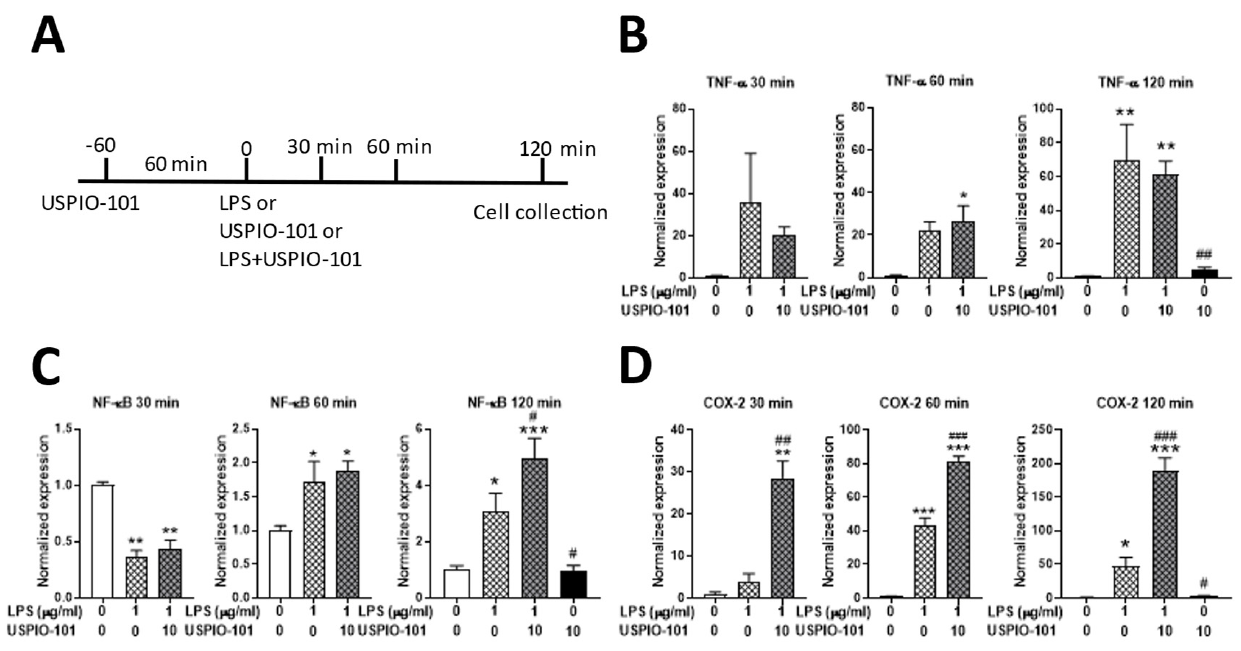
Figure 6. USPIO-101 potentiates the LPS-induced NF-kB and COX-2 mRNA expression in SM826 microglial cells. ( A ) The time scale for treating USPIO-101 and LPS stimulation. ( B – D ) The levels of mRNAs encoding the pro-inflammatory cytokines TNF- α ( B ), NF- κ B ( C ), and COX-2 ( D ) were analyzed by qRT-PCR and normalized by the expression of GAPDH (glyceraldehyde-3-phosphate dehydrogenase) at three time points after LPS stimulation: 30, 60, or 120 min. Data are presented as mean ± SEM ( n = 4). * or ** or ***: p < 0.05, or p < 0.01, or p < 0.001 vs. control; # or ## or ###: p < 0.05, or p < 0.01, or p < 0.001 vs.